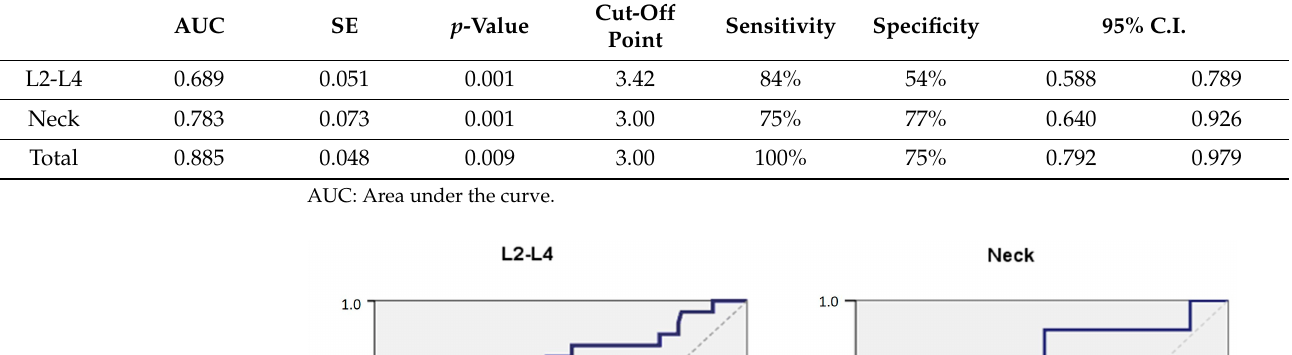
Table 7. ROC analysis of MCW with T-score in the lumbar spine and femoral neck.